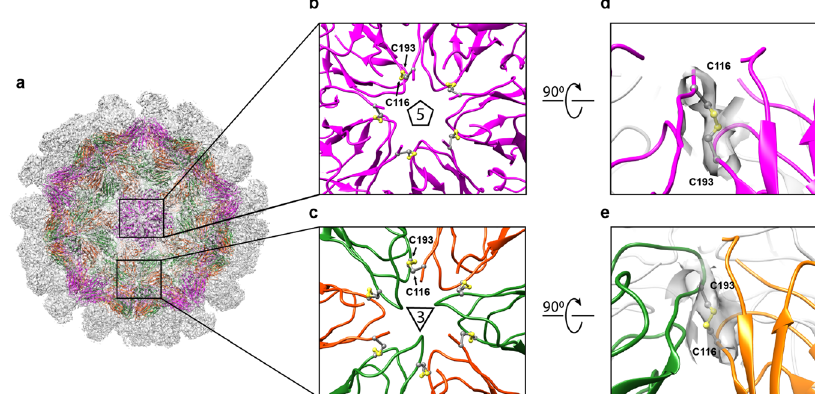
Fig. 3 Cryo-EM reconstruction of GI.1 DS1 VLP provides details of interprotomer disul fi de bonds between Cys116 and Cys193. a Overall electron density of GI.1 DS1 VLPs. Atomic model of the shell is colored according to each nonequivalent monomers. Monomers A, B, and C are shown in magenta, orange, and green, respectively. b , c Close-up view of the region around b the strict fi vefold and c threefold symmetry axes of the icosahedron. d , e Details of the electron density for one of the interprotomer disul fi de bond between d A – A monomers and e B – C